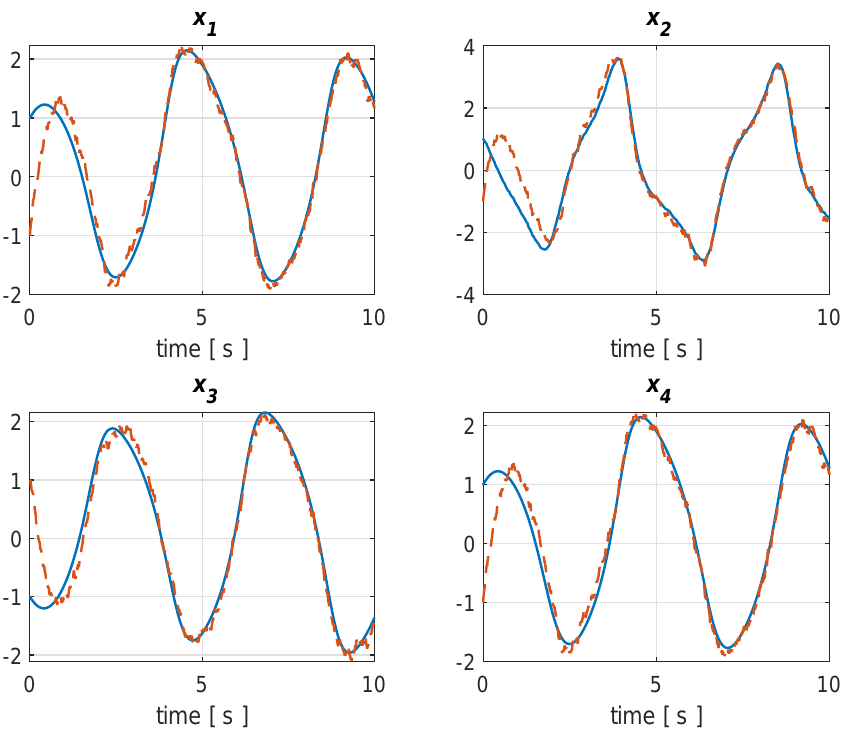
Figure 2. Simulation run with uniformly distributed noises w i , i = 1,2,3,4, in [ − 1,1 ] , x ( 0 ) = ( 1,1, − 1, − 1 ) , and ˆ x ( 0 ) = ( − 1, − 1,1,1 ) , where the state variables are in blue and their estimates are in dashed red.